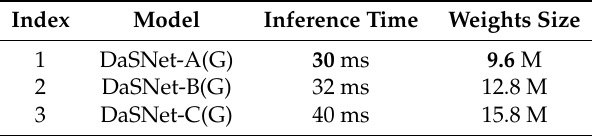
Table 3. Time efficiency and weights size of developed model (tested on